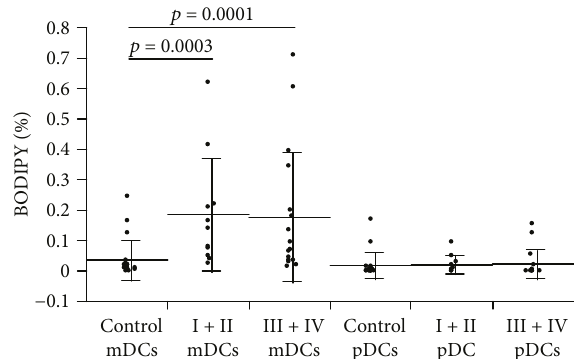
Figure 5: BODIPY 650/665 fl uorescence intensity in mDC and pDC. This fi gure shows the percentages of HLA-DR(+), Lineage( − ) DCs, and BODIPY-positive mDCs and pDCs. Signi fi cantly, more mDCs were observed in stage I+ II and stage III+IV lung cancer patients than in the controls.